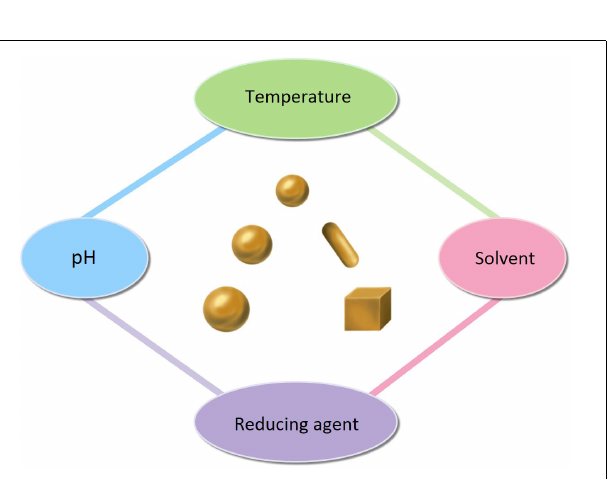
FIGURE 5 | The chemical synthesis of AuNPs using different reaction conditions.